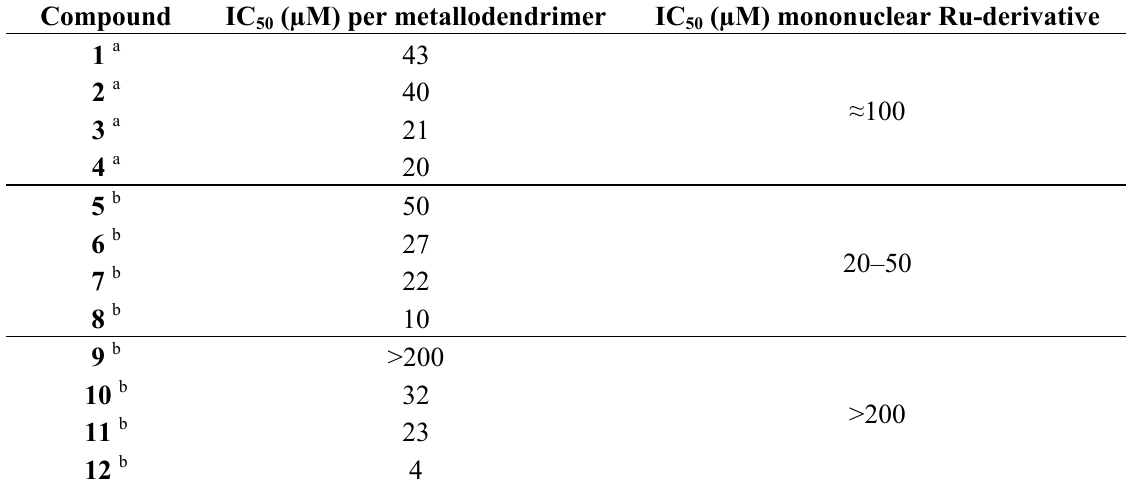
of ruthenium Metallodendrimers 1 – 12 on A2780 human ovarian cancer cells Table 1. IC 50 after 72 h of exposure.